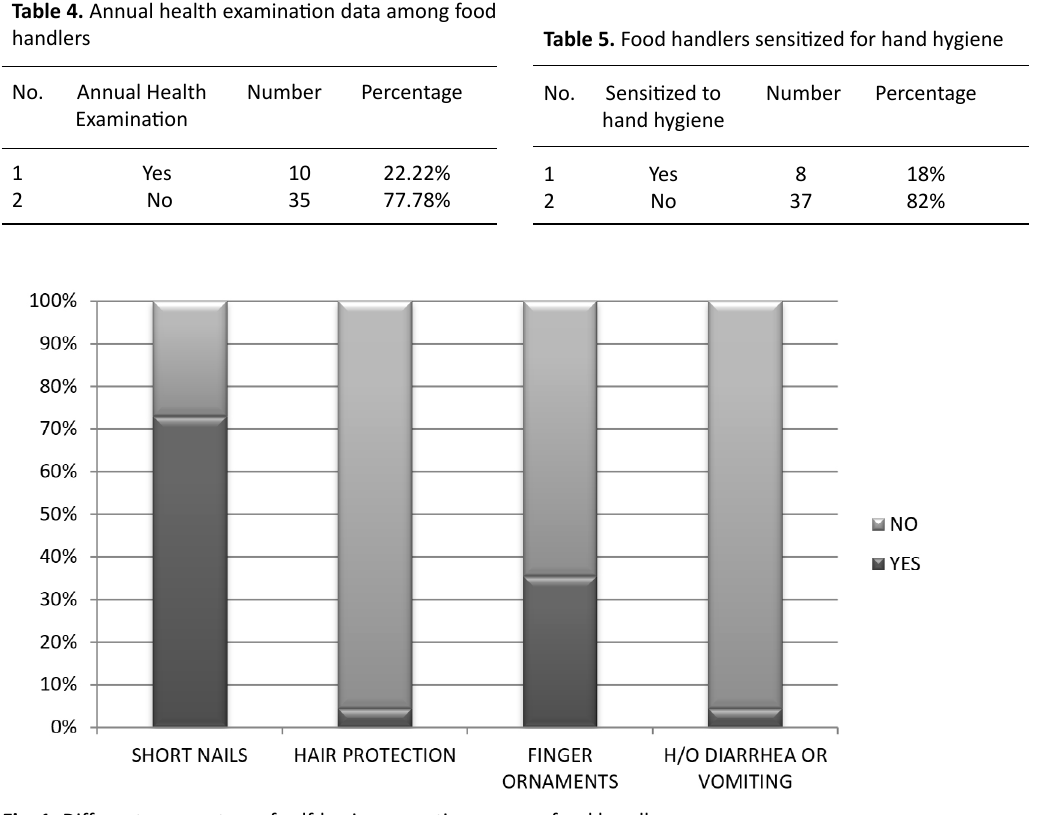
Fig. 1. Different parameters of self-hygiene practices among food